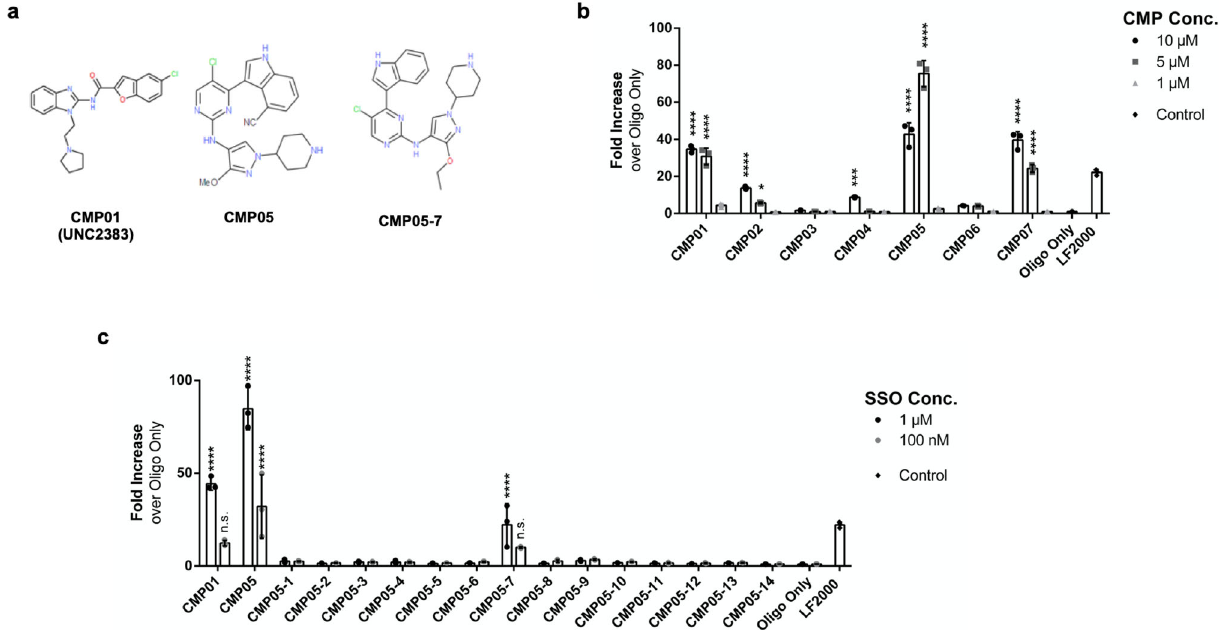
Fig. 1 Assessing endosomolytic compounds for their ability to increase functional SSO activity. a Chemical structures of CMP01, CMP05, and CMP05- 7. b Functional SSO activity during co-treatment with chosen compounds. HeLa_Luc705 cells were pre-treated with 1 µ M SSO, and then co-treated with 10 µ M, 5 µ M, or 1 µ M of the compound for 2 h . Cells were then rinsed and incubated for 4 h in growth media. Data come from N = 3 experiments, each with n = 3 biological replicates. Values are reported as fold increase over activity from 1 µ M naked SSO. Signi fi cance was determined (excluding LF2000) by two-way ANOVA followed by Dunnett ’ s posttest to the oligo only control where **** P < 0.0001, *** P < 0.001, * P < 0.05, and n.s = not signi fi cant. c Functional SSO activity during co-treatment with CMP05 analogs. HeLa_Luc705 cells were exposed to 5 µ M of the compound and either 1 µ M SSO or 100 nM SSO for 2 h. Cells were then rinsed and incubated for 4 h in growth media. Values are reported as fold increase over activity from 30 h treatment with 1 µ M naked SSO. Data comes from n = 3 experiments. Signi fi cance was determined (excluding LF2000) by two-way ANOVA followed by Dunnett ’ s post test to the oligo only control where **** P < 0.0001 and n.s = not signi fi cant. Intraexperimental variability can contribute to discrepancies in fold increase between